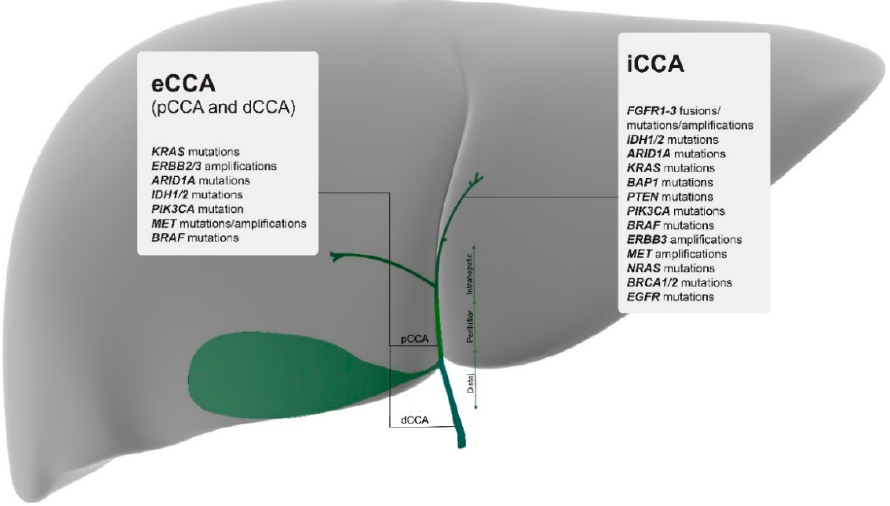
Figure 1. Molecular mapping of the most relevant actionable gene alterations based on tumour location and listed from highest to lowest percentages [12]. iCCA = intrahepatic cholangiocarcinoma; pCCA = perihilar cholangiocarcinoma; dCCA = distal cholangiocarcinoma; eCCA = extrahepatic cholangiocarcinoma.